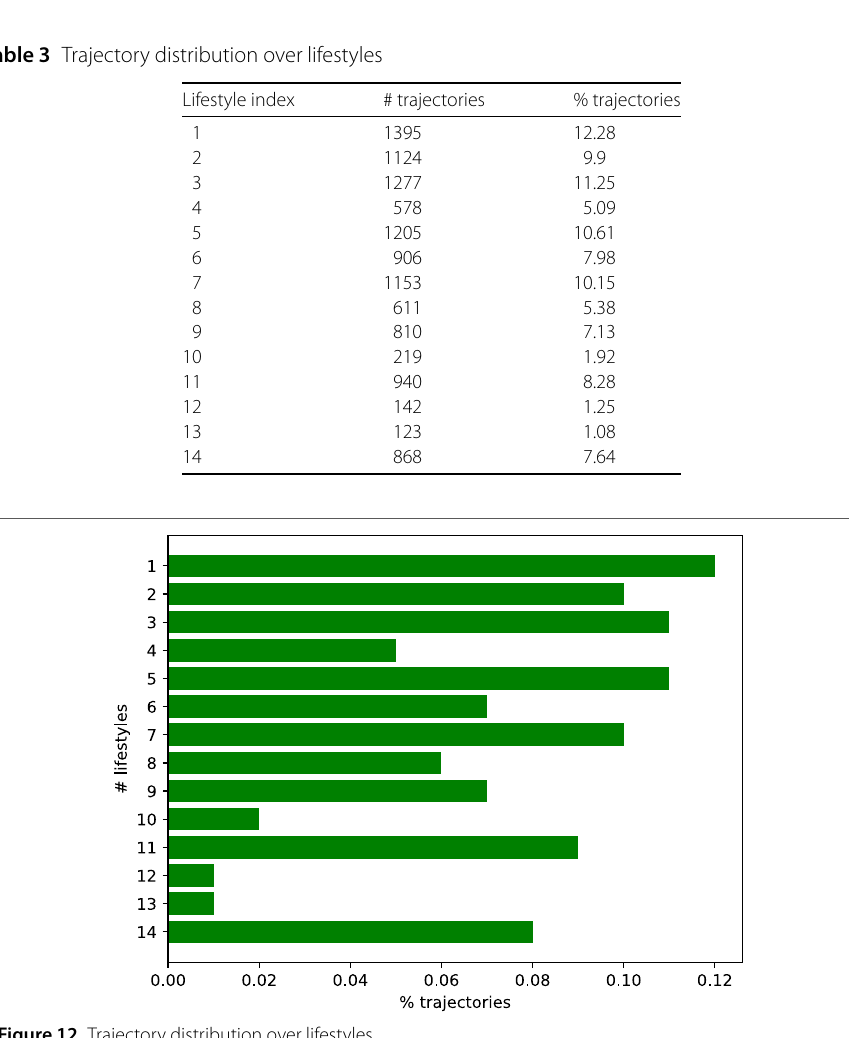
Figure 12 Trajectory distribution over